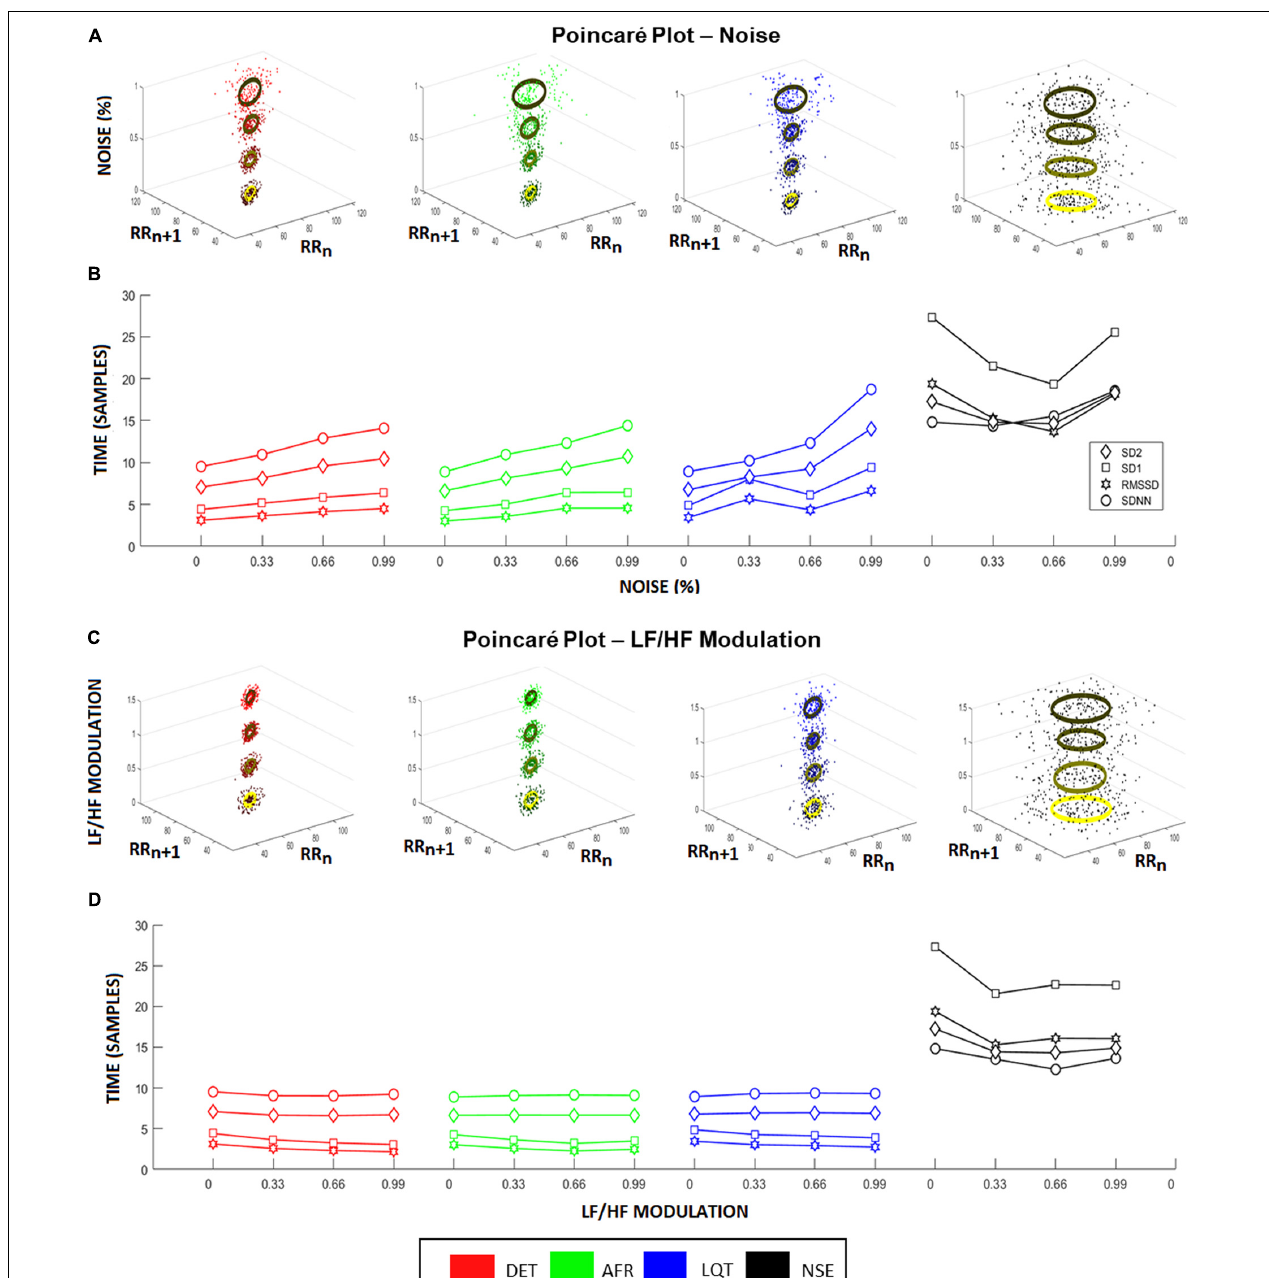
FIGURE 4 | Heart rate variability (HRV) coefficients from aECG signals. (A) Higher noise levels spread the Poincaré Maps, raising both, SD1 and SD2, for all groups except noisy ECG signal (NSE). This raise is highlighted in (B) , where it represents the changes in HRV characteristics according to different noise levels. In this situation, all coefficients raise linearly according to the increasing of noise levels, where RMSSD showed to be the more sensitive coefficient. (C) Changes in Poincaré plot according to LF/HF modulation is observed. In this picture, the colors represent the different intensities of LF/HF modulations. Higher LF/HF values produce higher radius values of Poincaré Map ellipses, emphasizing the differences between SD1 and SD2 coefficients for every group. (D) It shows the HRV coefficient values variating according to different LF/HF ratio values. Long-time coefficients, SDNN and SD2, become stable as short-time coefficients, SD1 and RMSSD, decrease their